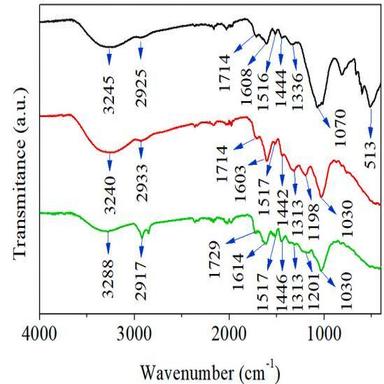
Fourier-transform infrared (FTIR) spectra of the following samples: ( ) EG leaves, ( ) EG leaves extract and (—) EGnZVI.